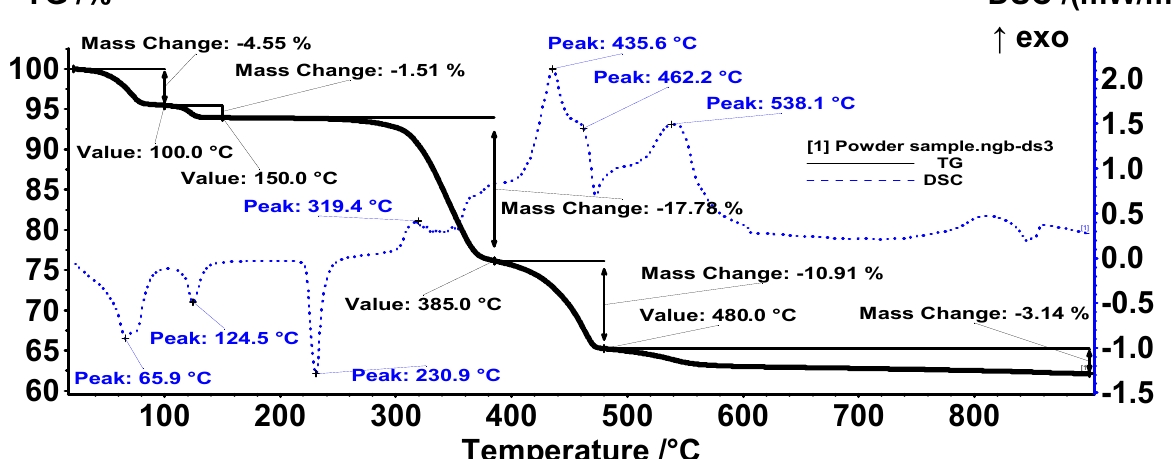
Figure 1. Thermal analysis of ZnO powder.